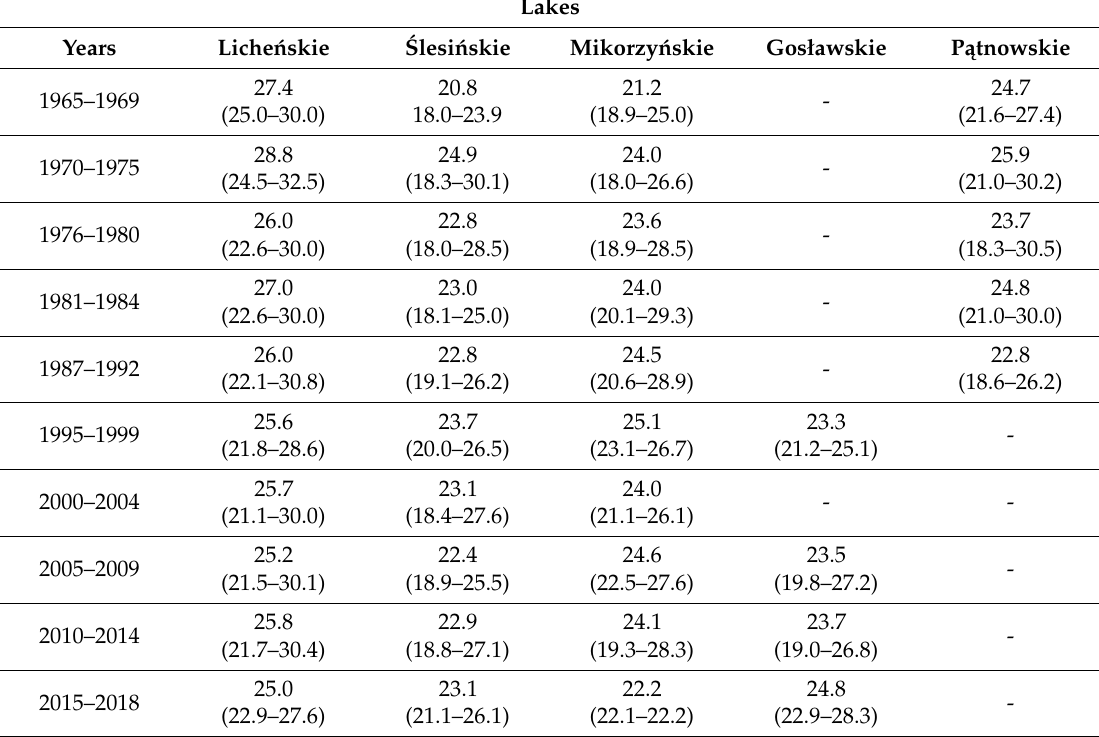
Table 2. Water temperature: mean (and range) in the epilimnion of the Konin lakes in the summer